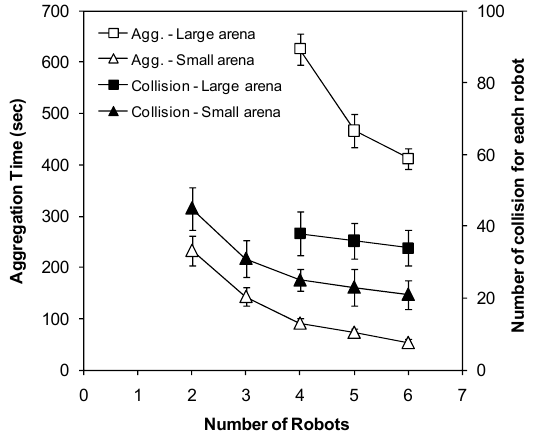
Fig. 7. (a) Aggregation with threshold level of 600 and (b) aggregation with threshold level of